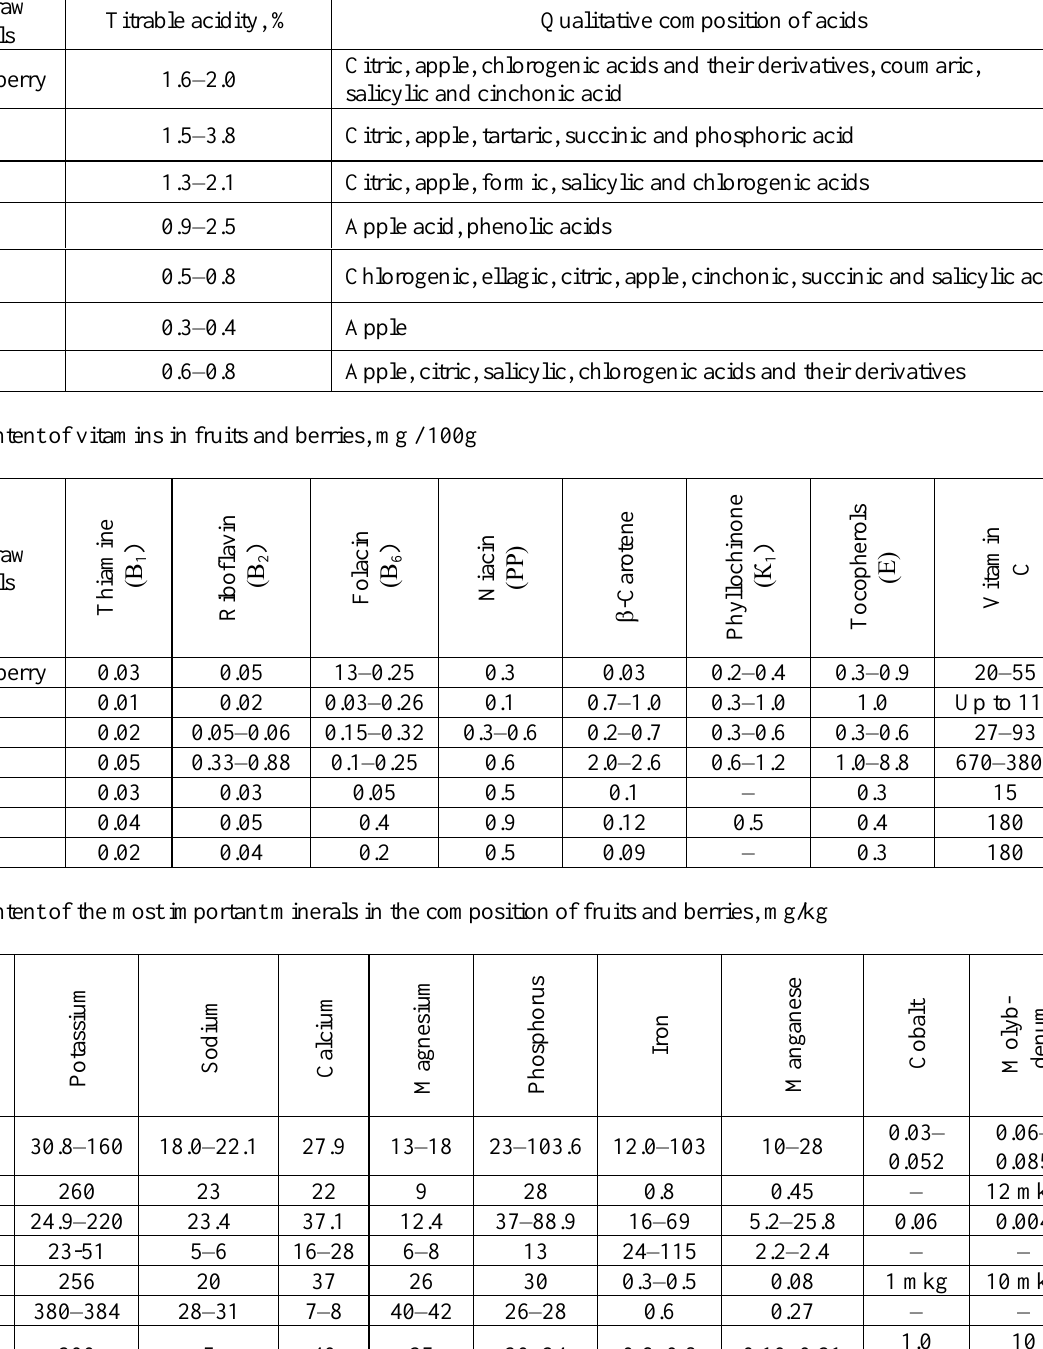
Table 2. Titrable acidity and composition of organic acids Type of raw